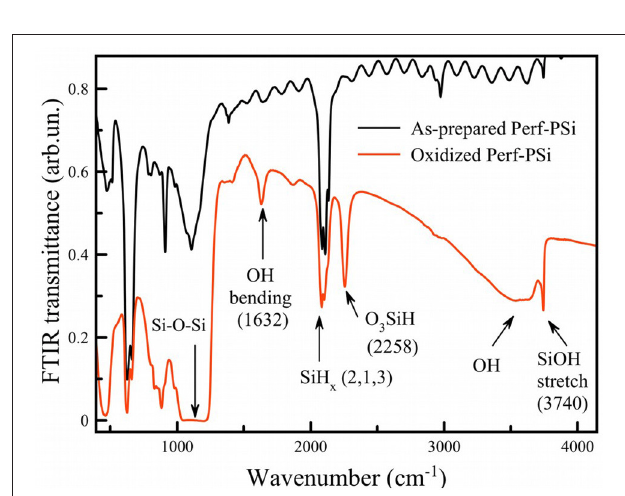
FIGURE 7 | FTIR transmission spectra of as-prepared (black curve) and borax-oxidized (red curve) PSi